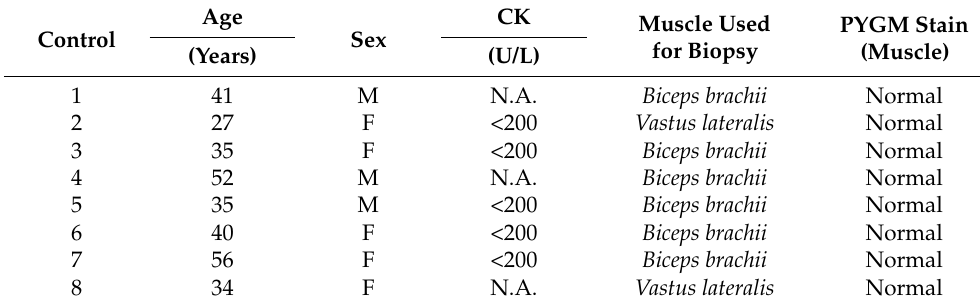
Table 2. Main characteristics of the healthy control